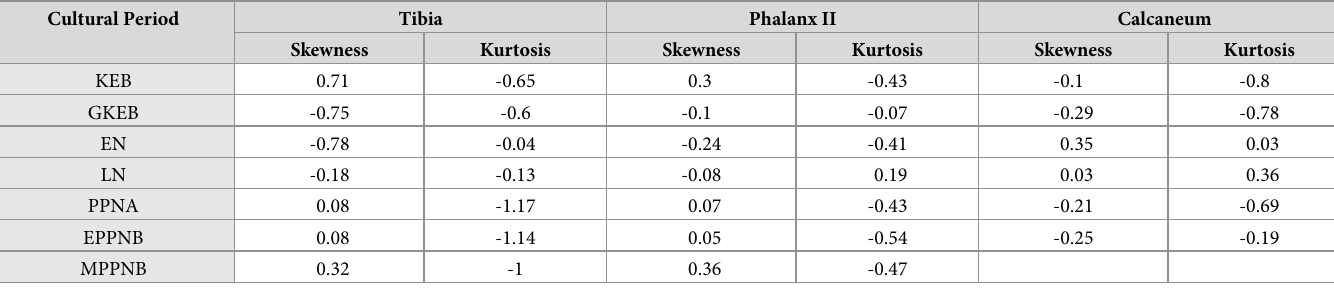
Skewness values greater than 1 or less than -1 are highly skewed. Values between 0.5 and 1 and -0.5 and -1 are moderately skewed. Negative skewness values skew toward the smaller measurement, while positive values are